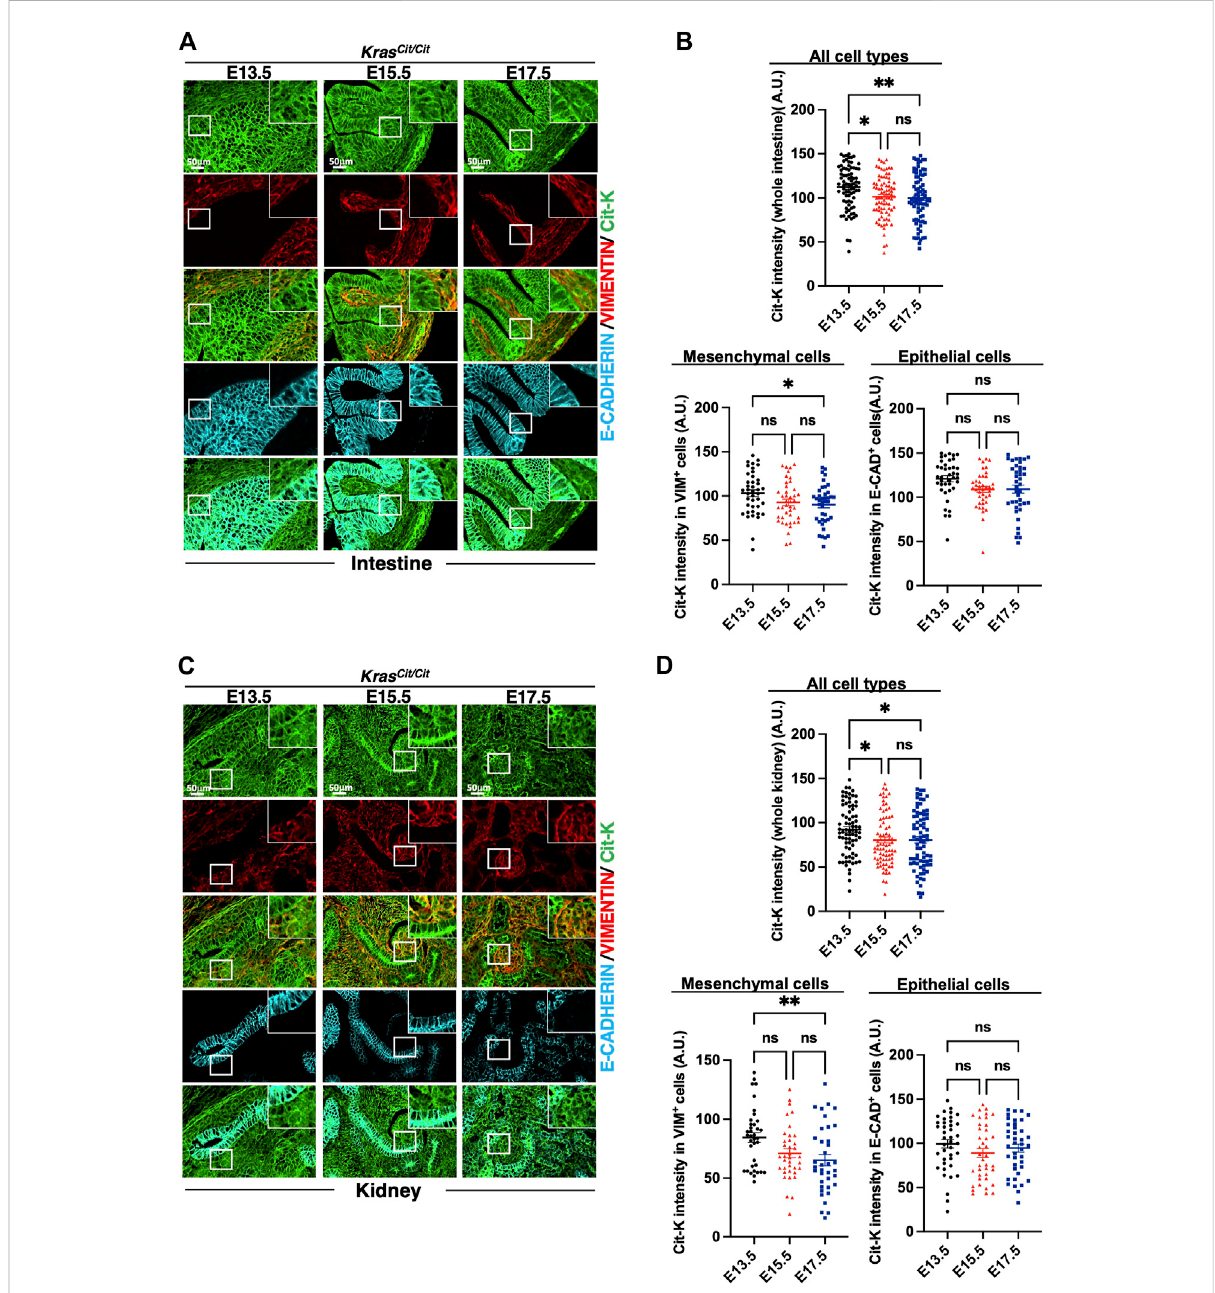
Cit-K expression is found in the developing intestine and kidney. (A,C) Immunolabeling for Cit-K, VIMENTIN (VIM) and E-CADHERIN (E-CAD) performed on embryonic intestine (A) and kidney (C) sections of Kras Cit/Cit embryos at E13.5, E15.5 and E17.5. (B,D) Quanti fi cation by FIJI software of Cit-K signal intensity in mesenchymal (VIM + ) and epithelial (E-CAD + ) cells of the embryonic intestine (B) and kidneys (D) . One dot represents the mean of three measures of signal intensity of one cell. Data are represented as mean+/-SEM of 80 (n = 4 embryos). Statistical signi fi cance was tested by Student ’ s t -test. *, p < 0.05; ns, not signi fi cant. A.U. arbitrary